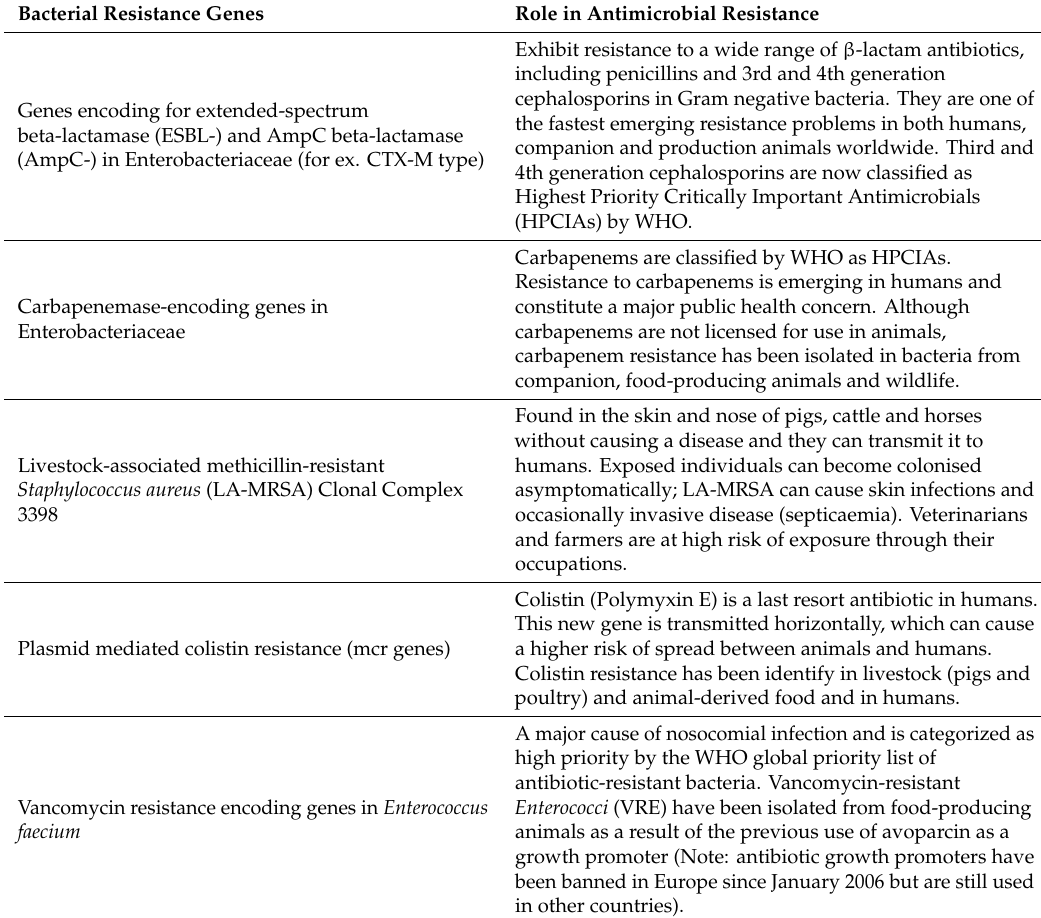
Table 2. Examples of bacterial genes and their roles in antimicrobial resistance. Bacterial Resistance Genes Role in Antimicrobial